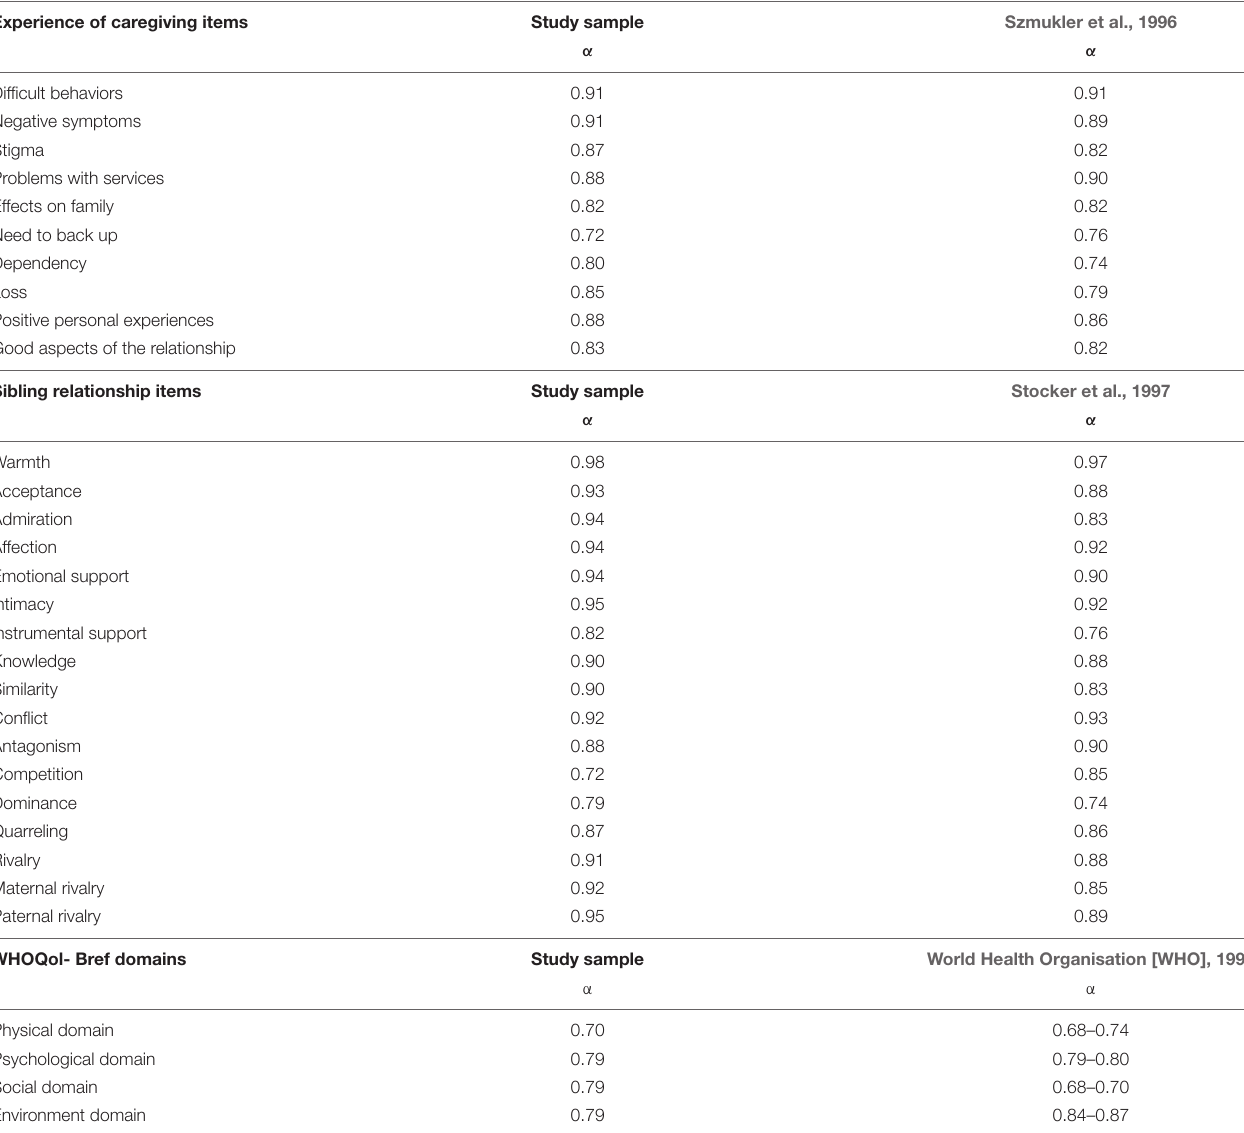
TABLE 8 | Cronbach alpha coefficient for the Experience of Caregiving Inventory (ECI) (Szmukler et al., 1996), the Adult Sibling Relationship Questionnaire (ASRQ) (Stocker et al., 1997). Experience of caregiving